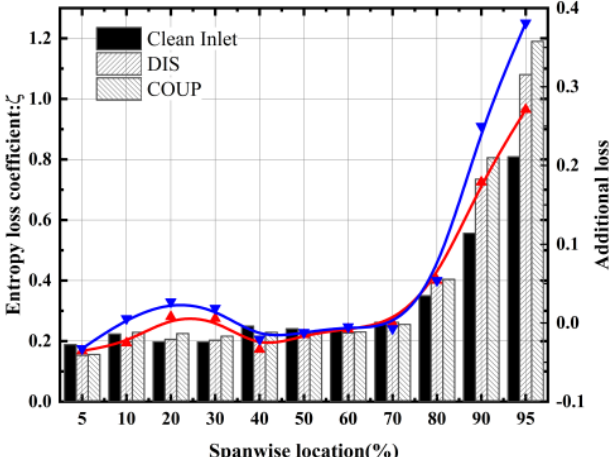
Figure 9. Comparison of the entropy loss coefficient at different spanwise locations in various cases.